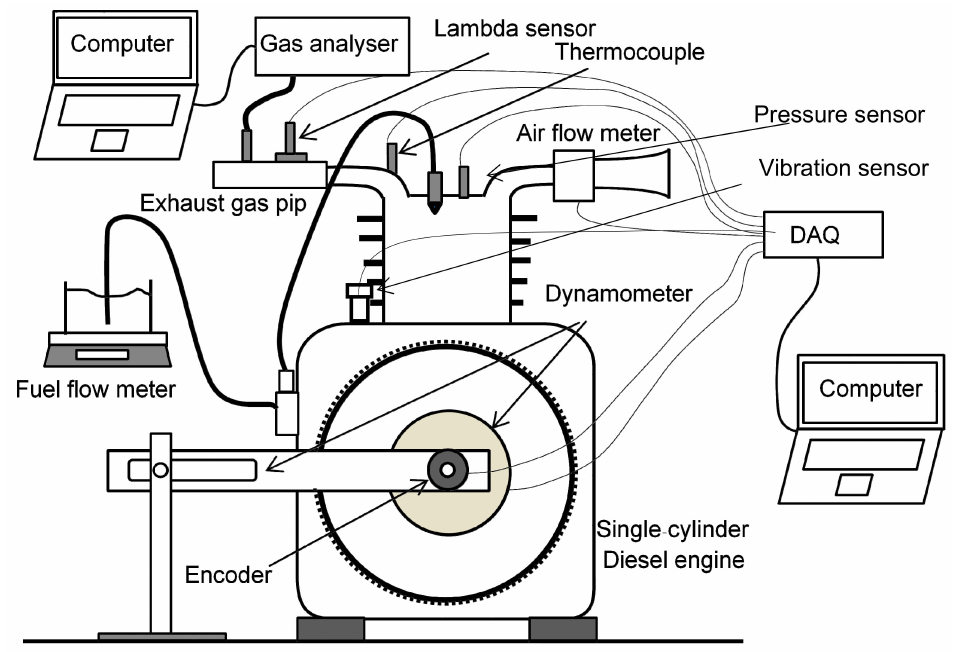
Figure 2. Schematic diagram of the experimental